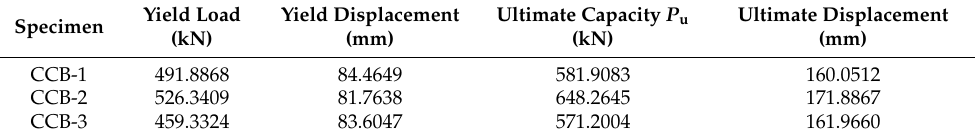
Table 5. Yield load and capacity of test specimens.